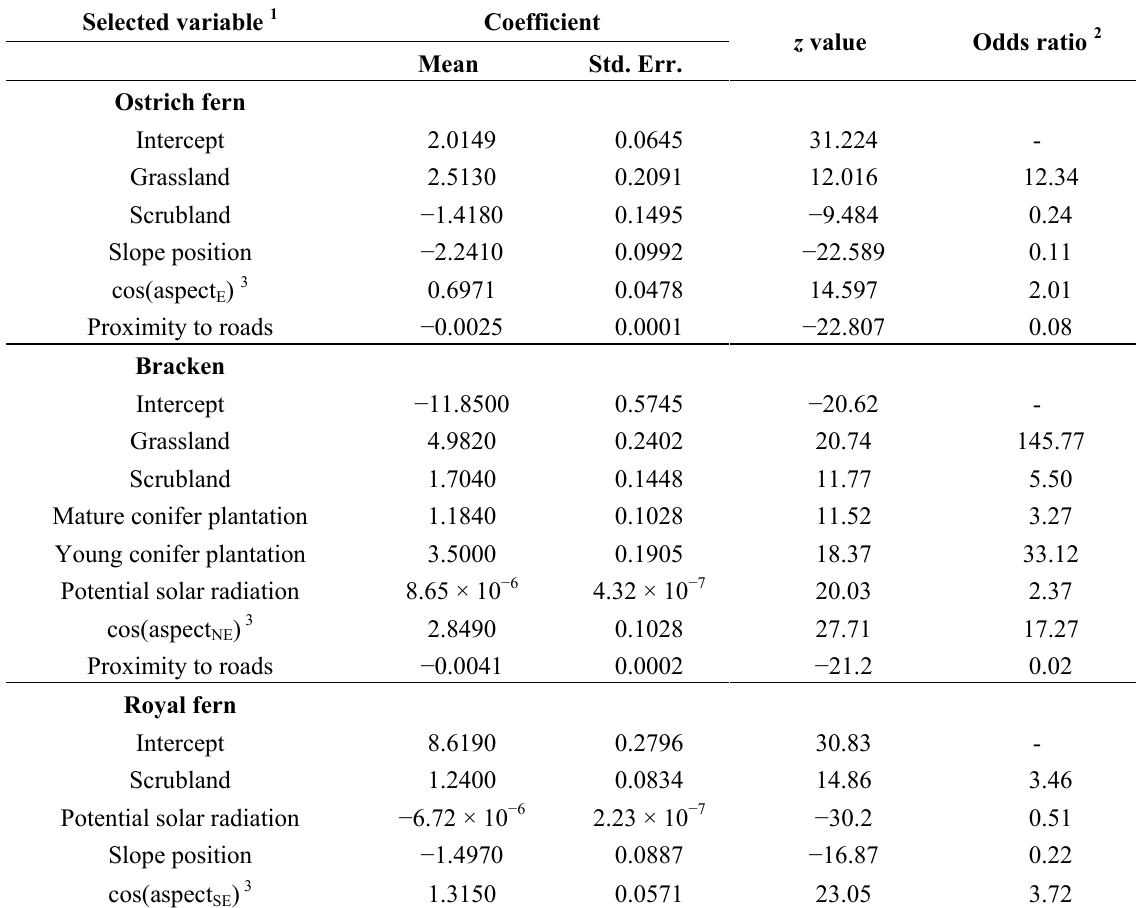
Table 3. Results of generalized linear models (GLMs).